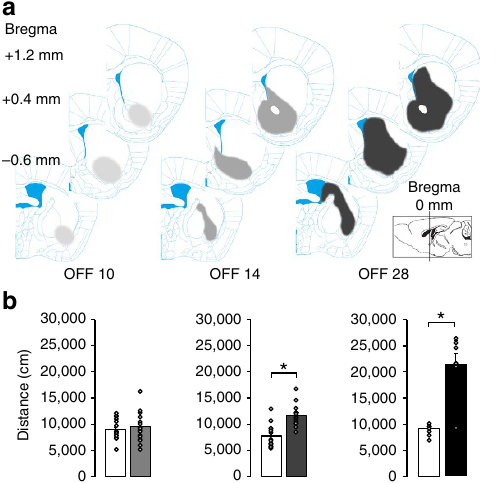
Figure 2 | Anatomical expansion of Drd2 mRNA disappearance area and behavioural readout. ( a ) Stepwise expansion of Drd2 mRNA disappea- rance from the rostral to the caudal striatum (grey area) is illustrated. ( b ) Locomotor activity in the open field test. Significant increases in total distance were observed in the 14- and 28-day groups, but not in the 10-day group. Bars represent the mean and lines represent the s.e.m. * P o 0.05, Student’s t -test.